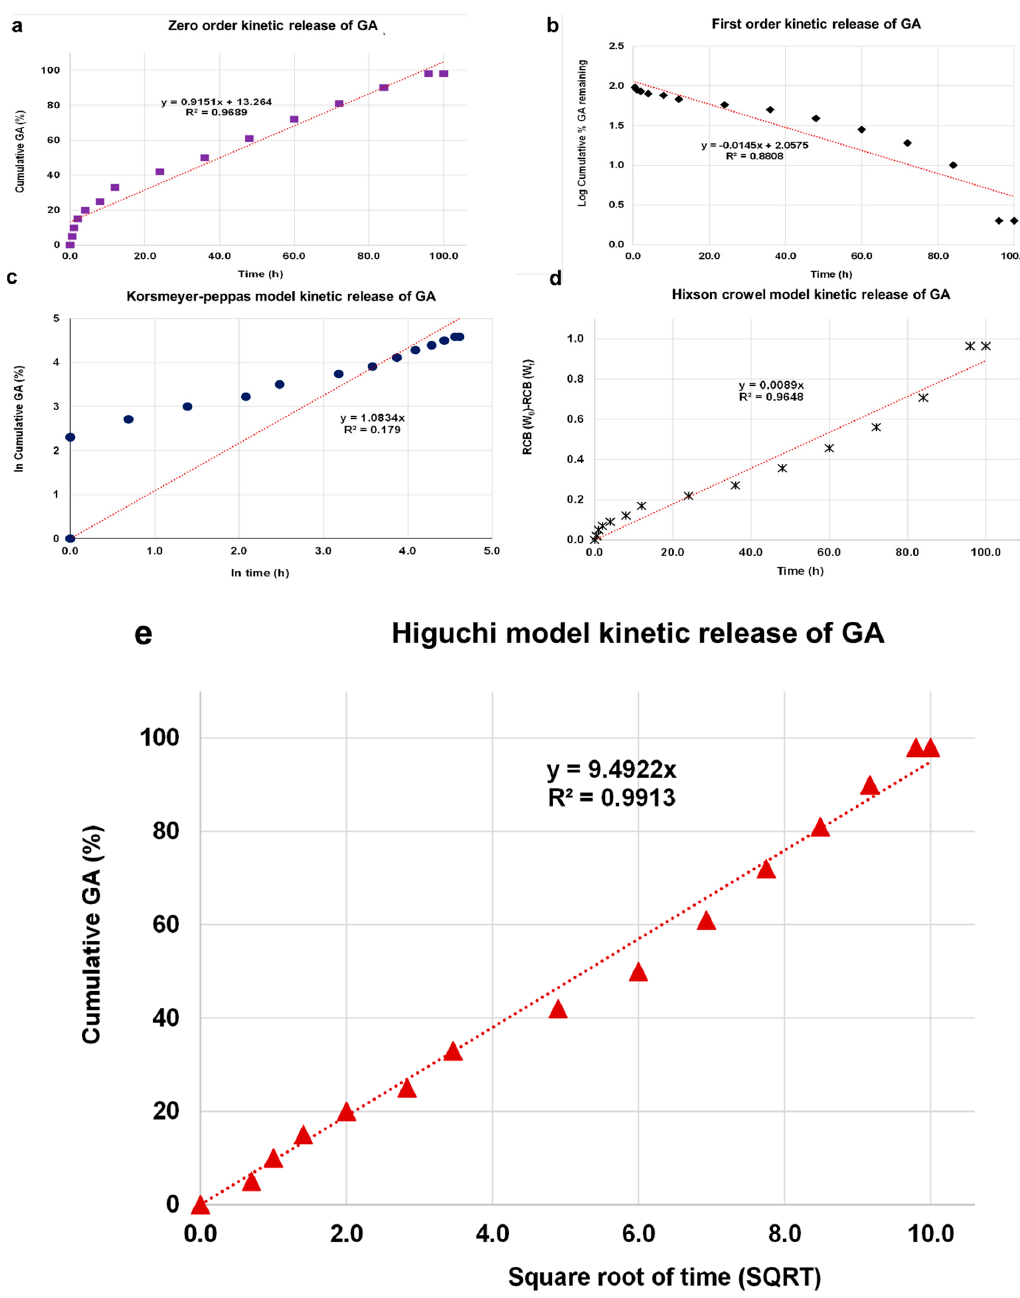
Figure 9. Fitting the data of GA release from GALD nanocomposite at pH 7.4 for kinetic models: ( a ) zero-order model; ( b ) first-order model; ( c ) Korsmeyer–Peppas model; ( d ) Hixson–Crowel model and ( e ) Higuchi model.